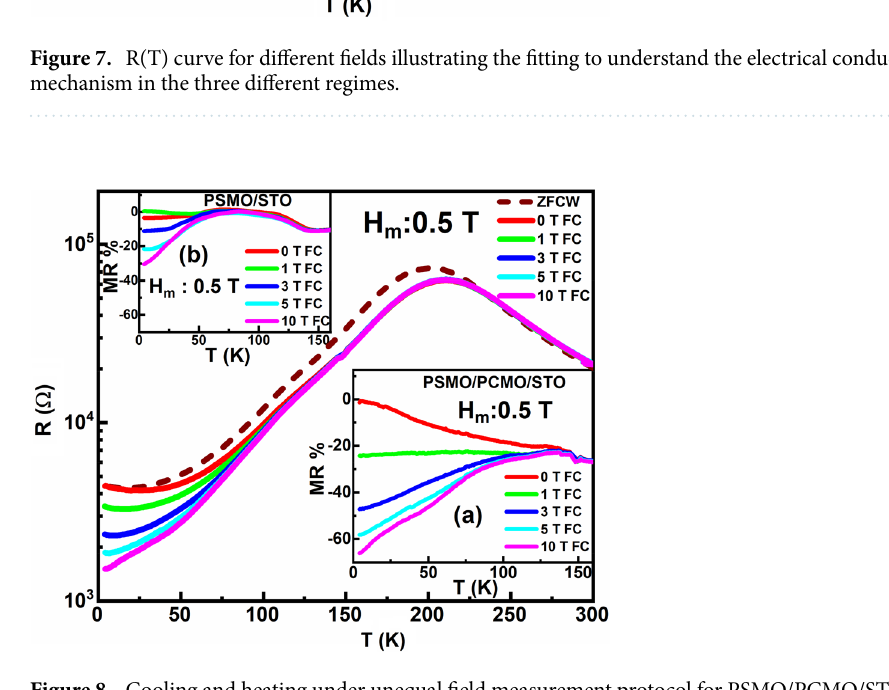
Figure 8. Cooling and heating under unequal field measurement protocol for PSMO/PCMO/STO heterostructure for H m = 0.5 T. The inset ( a ) shows the MR% of the kinetically arrested FM phase in the heterostructure. The inset ( b ) shows similar measurements on annealed PSMO/STO thin